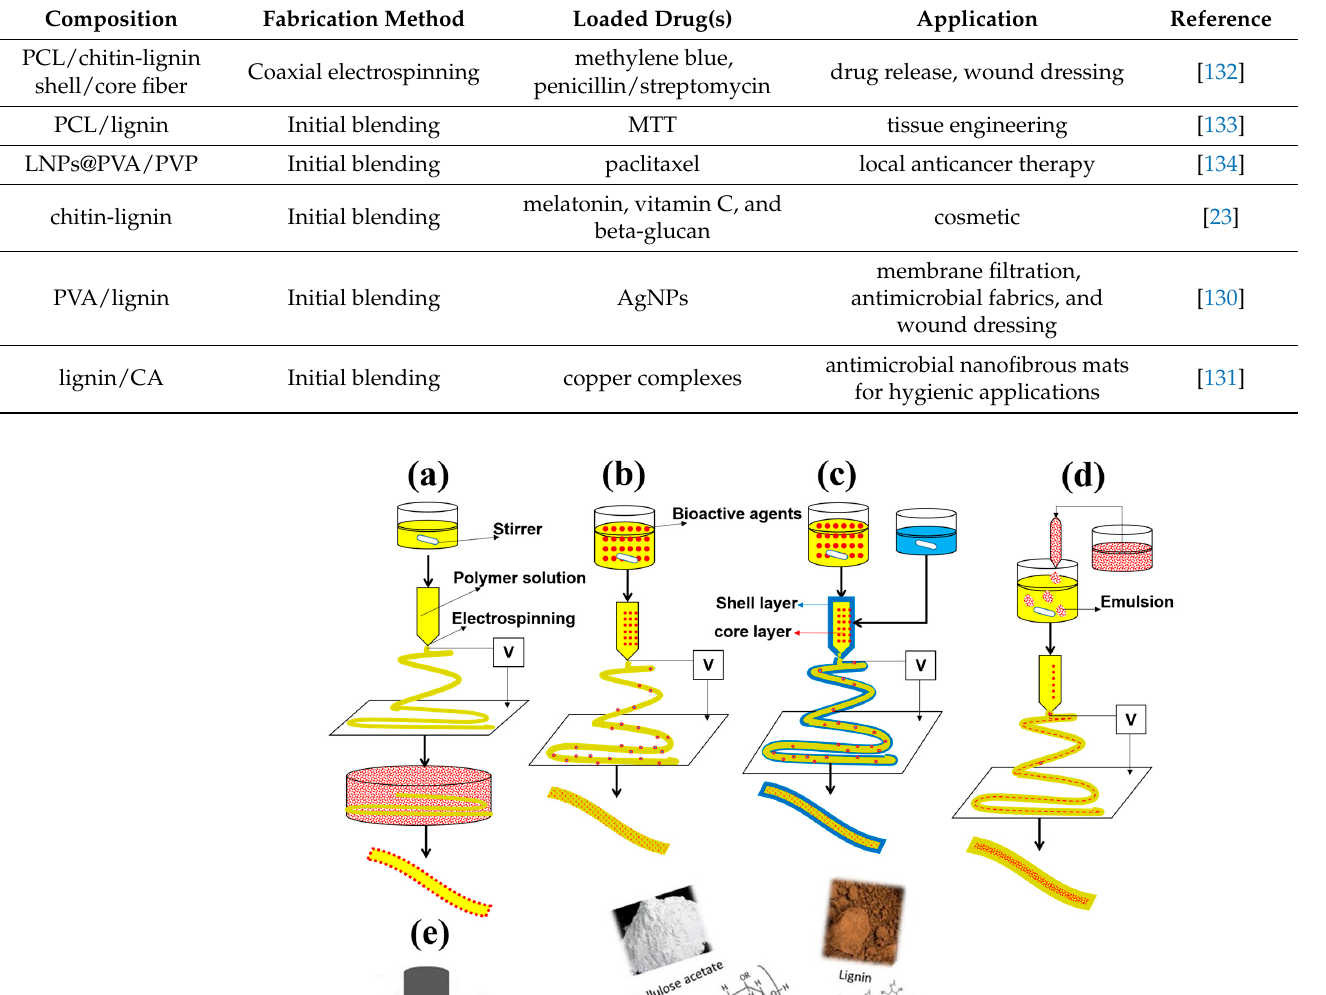
Table 3. Lignin-based electrospun scaffolds applied for delivery of various bioactive